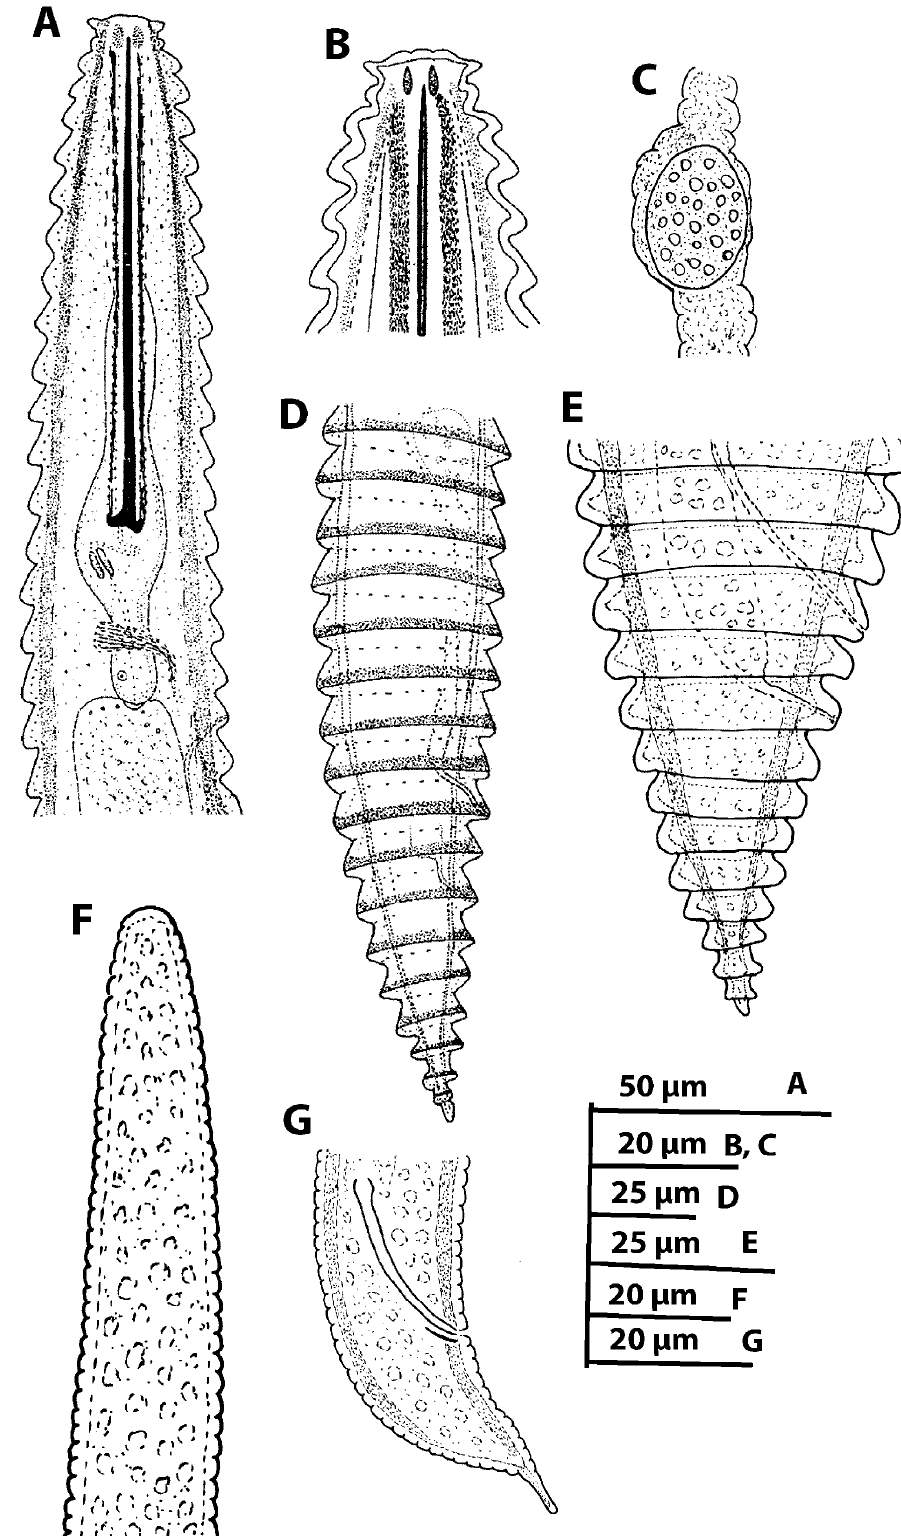
Figure 7. Line drawings of Criconema plesioannuliferum sp. nov. ( A ), female pharyngeal region; ( B ), detail of female lip region; ( C ), detail of spermatheca; ( D , E ), female posterior region; ( F ), male anterior region showing absence of stylet; ( G ), male posterior